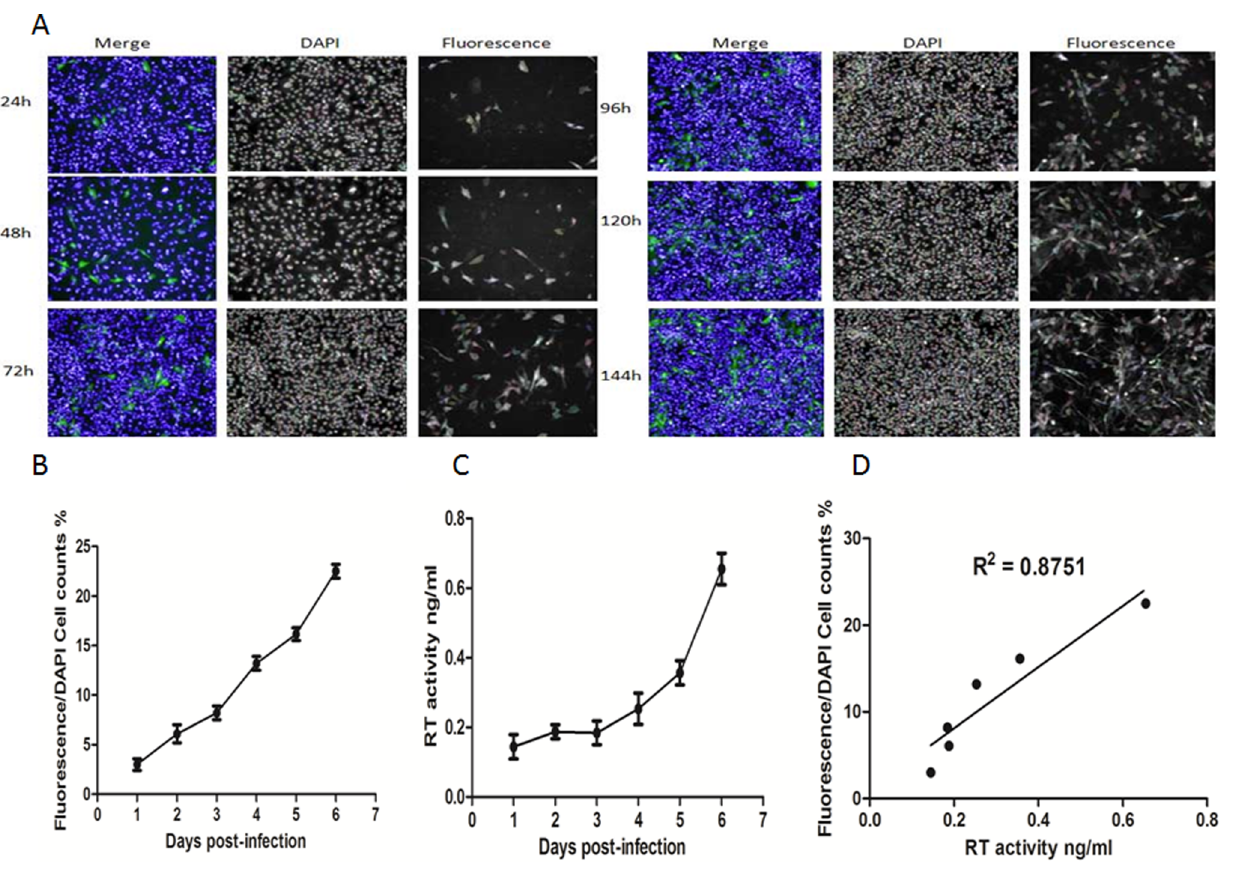
Fig. 3. Characterization of rHPRS-103EGFP and the correlation between fluorescence levels and ALV-J replication. A, Time-lapse fluorescence microscopy for the spread of rHPRS-103EGFP. DF-1 cells were infected with HPRS-103EGFP and cells fixed and stained with DAPI every 24 h for a period of 6 days. B, The percentage of EGFP-positive cells shown in A. C, During the time-lapse fluorescence microscopy of rHPRS-103EGFP, the supernatants of rHPRS-103EGFP-infected cells were examined for RTactivity. D, Correlation between the RTactivity and the EGFP positive cells. The viral titers harvested at different intervals were calculated and expressed as TCID 50 per milliliter. The RT activity was quantitated using a colorimetric Reverse Transcriptase Assay (see Methods). The standard deviations (error bars) from 3 independent experiments are shown.